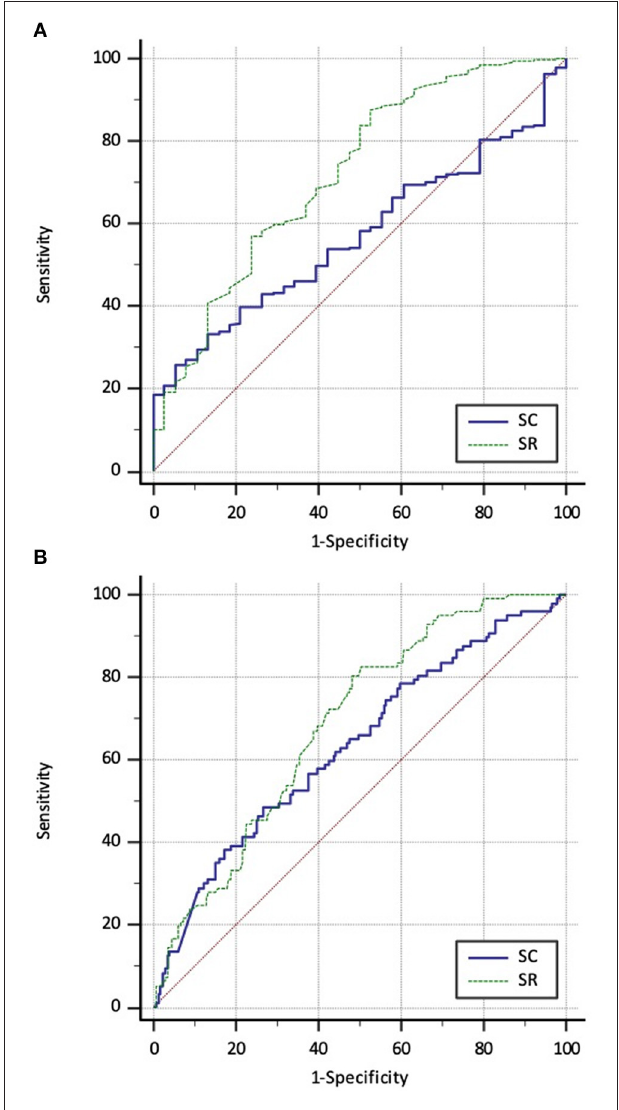
FIGURE 4 | (A) Comparison of ROC curves of SR and SC for differentiating perineal fistulae from bulbar and prostatic/bladderneck fistulae ( p < 0.01). (B) Comparison of ROC curves of SR and SC for differentiating bulbar fistulae from prostatic/bladderneck fistulae ( p = 0.21).